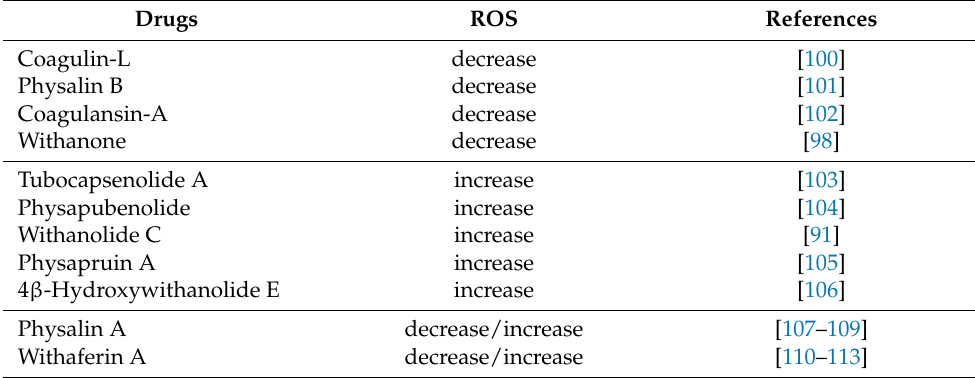
Table 2. Withanolides exhibit antioxidant and/or pro-oxidant effects. Drugs